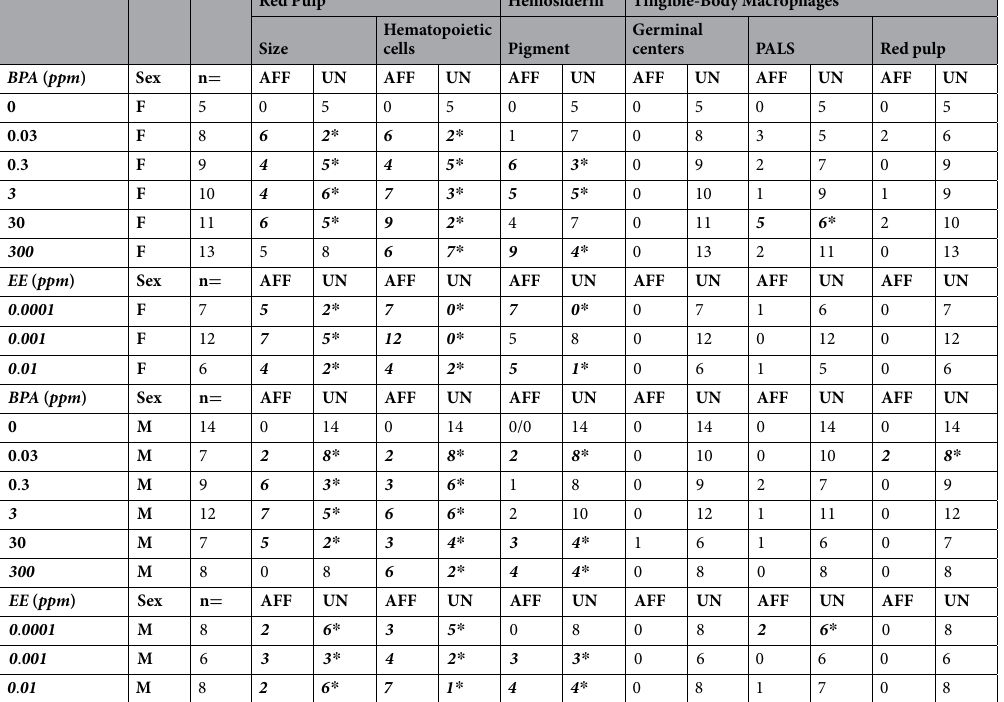
Table 3. Histopathology of Spleen Red Pulp, Tingible-Body Macrophages and Hemosiderin. Values are number of samples affected or unaffected. AFF: indicates affected; UN: indicates unaffected. Significant differences compared to same sex control are indicated in bold and italics font and by an *